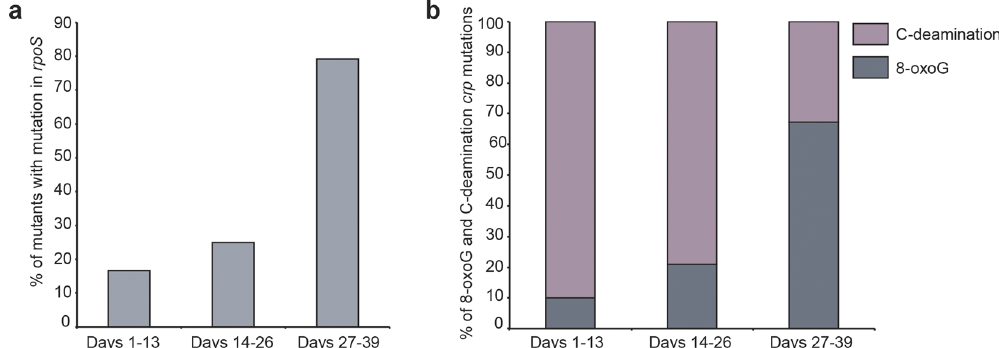
Figure 4. Time-dependent trends in mutational mechanisms. ( a ) The frequency of rpoS mutations in isolated mutants is increasing with time. The x-axis shows days after plating. ( b ) Isolated mutants show a distinct mutation pattern in the crp gene. Over time, there is a steady increase in mutations originating from guanosine (likely 8-oxo-G) whereas the C-deamination associated mutations